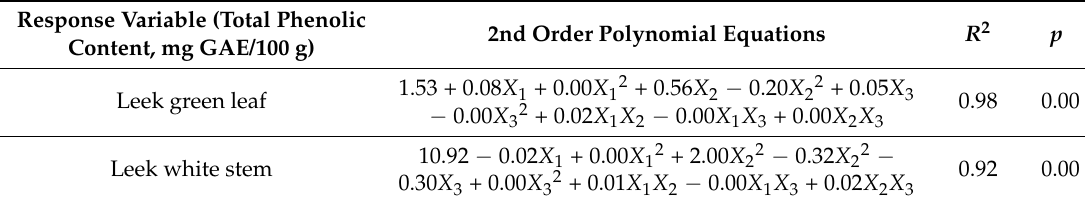
Table 2. Polynomial equations and statistical parameters calculated after implementation of a three-factor Box-Behnken experimental design.